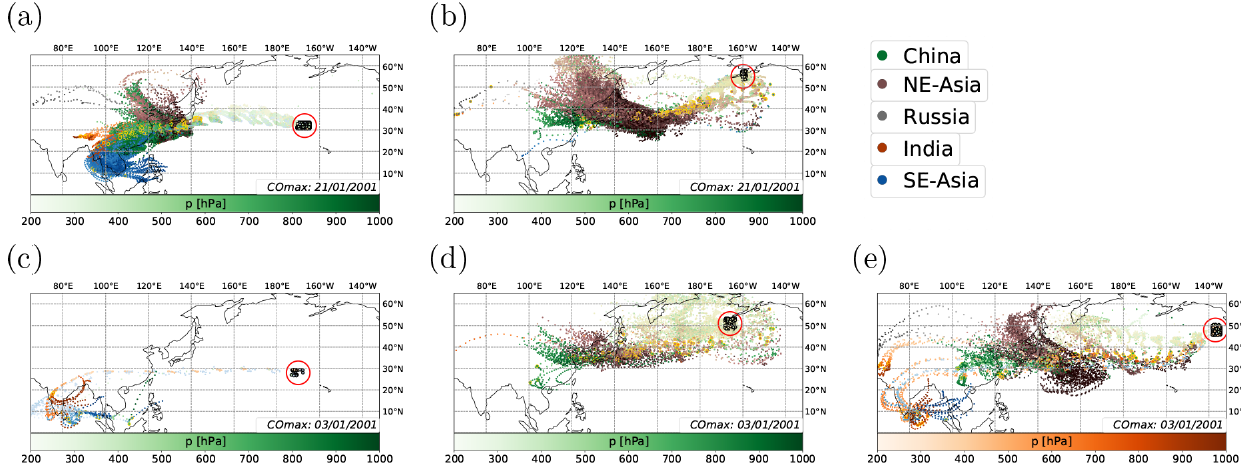
Figure 5. Plots show trajectories starting at a CO maxima cluster on 3 January 2001 (c, d, e) and 21 January 2001 (a, b) . Trajectories with the same source region have the same colour (see legend, e.g. trajectories from China are green, those from SE Asia are blue). The lighter the colour of the circles marking the position of the trajectory, the lower the pressure level. Yellow circles mark the time of uplift, and black circles (over the Pacific) mark the start position of the trajectory, i.e. the region of the CO maxima cluster.